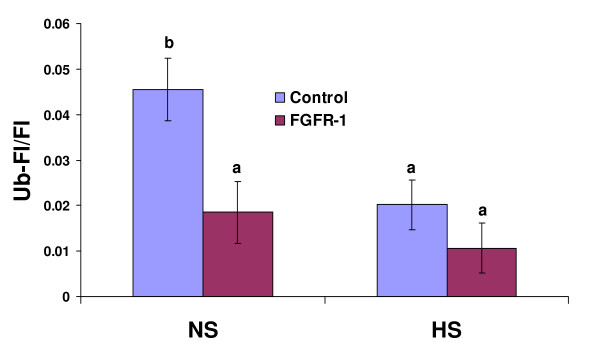
Proteasome activity is unaffected by overexpression of FGFR1 in muscle subjected to hindlimb suspension (HS). Luminescence of extracts from the gastrocnemius and soleus muscles of mice transfected with either control (control) or FGFR1 expression plasmid DNA (FGFR1), subjected to either hindlimb suspension (HS), or non-suspended controls (NS). Data are expressed as luciferase dependent light units of Ub-Fl normalized to renilla luciferase dependent light units. Means (±SEM) bearing different letters differ significantly (P < 0.05).